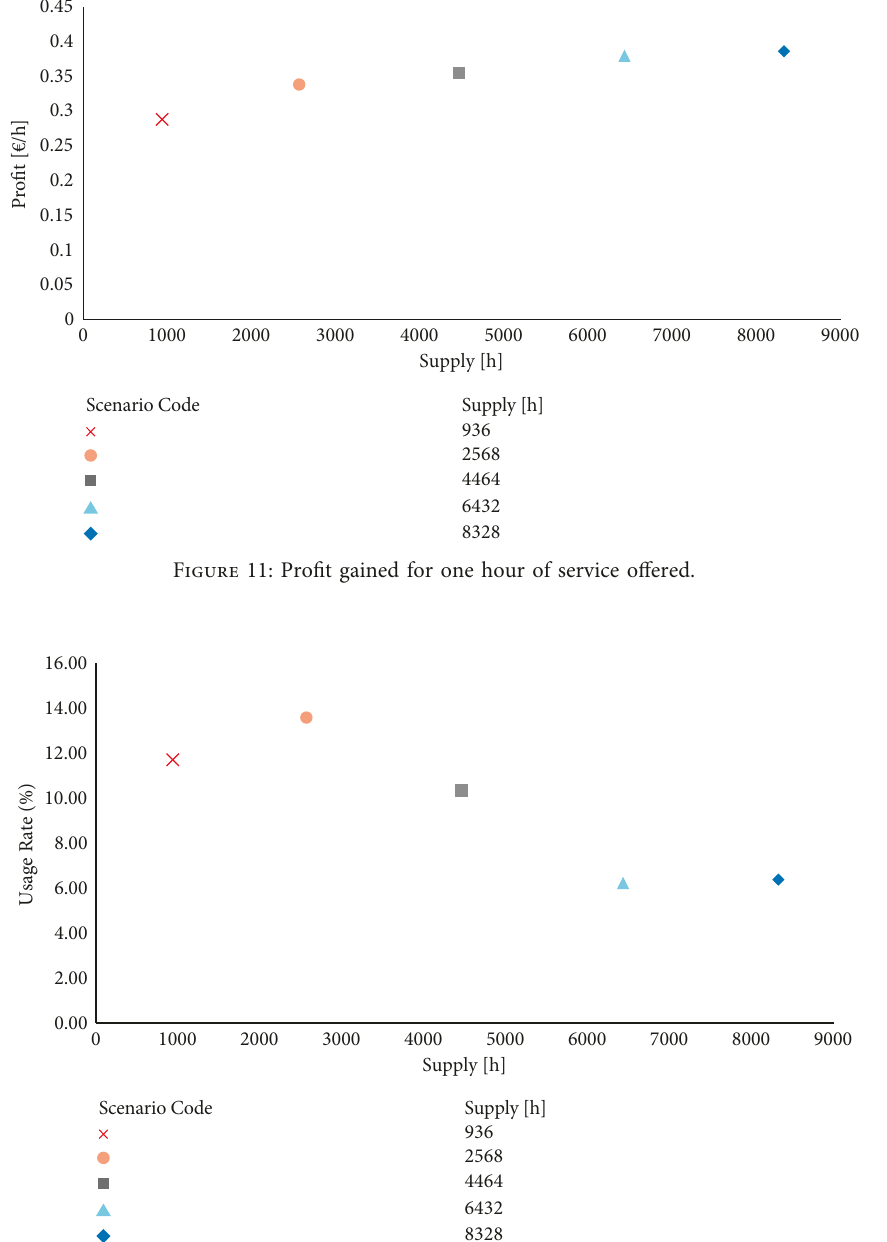
Figure 12: Usage